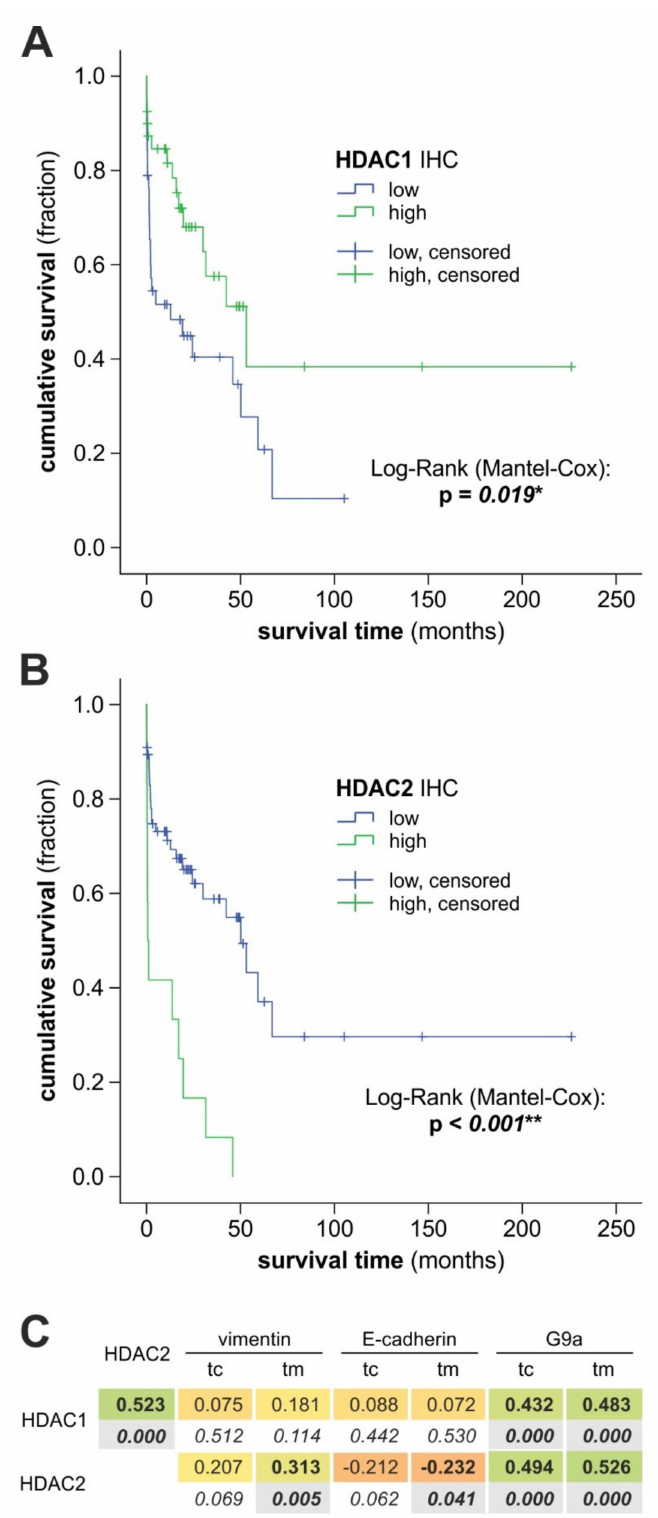
Figure 8. HDAC 1 and 2 expression is related to overall survival in BTC patients. ( A , B ) Survival curves comparing cases with high/low HDAC 1 ( A ) or HDAC 2 ( B ) expression. ( C ) Correlation analysis between HDAC 1/2 expression and the level of vimentin, E-cadherin, and G9a. Green boxes indicate a positive correlation, bold font a significant correlation. Abbreviations: BTC, biliary tract cancer; tc, tumor center; tm, tumor